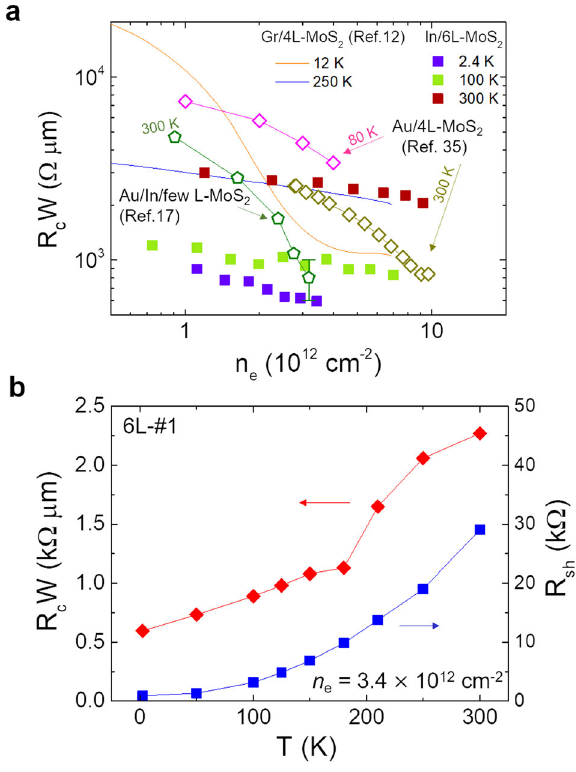
Fig. 6 Contact resistance with carrier density at In/MoS 2 contacts. a Contact resistance ( R c W ) as a function of carrier density ( n e ) of 6L- #1 MoS 2 device at various temperatures (scattered solid squares) with other works (solid curves: graphene(Gr)/4L-MoS 2 , opened diamonds: Au/4L-MoS 2 , opened pentagons: Au/In/few L-MoS 2 ). b R c W and sheet resistance ( R sh ) of 6L-#1 MoS 2 device as a function of T at n e = 3.4 × 10 12 cm − 2